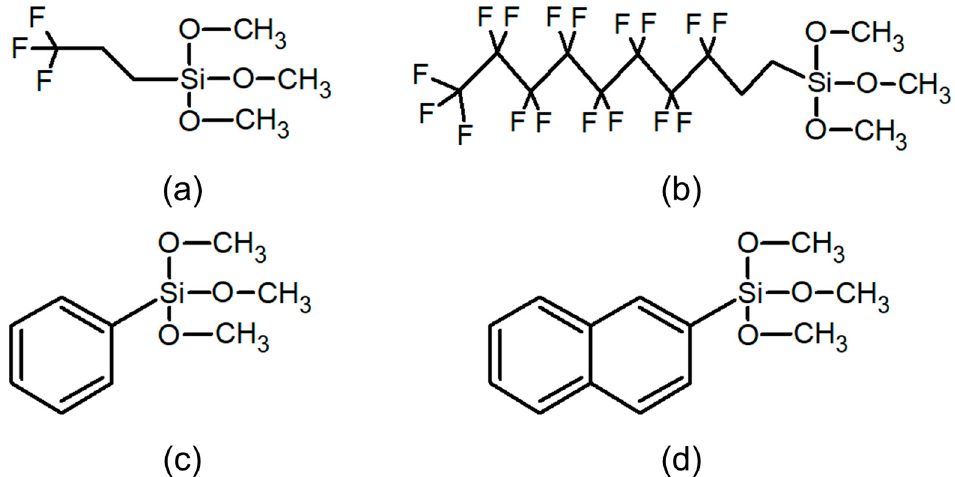
Figure 1. Molecular structures of SAMs: ( a ) (F3SAM), ( b ) F10SAM, ( c ) TTPS, ( d )